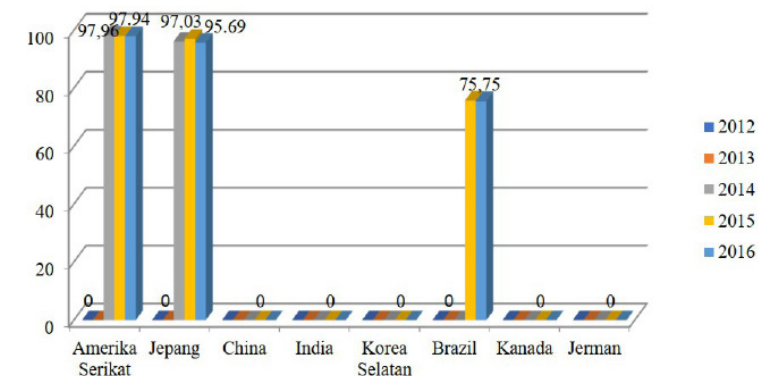
Figure 3: Coverage Ratio SPS (%) at Natural Rubber Export (TSNR) to Major Destination Countries 2012-2016